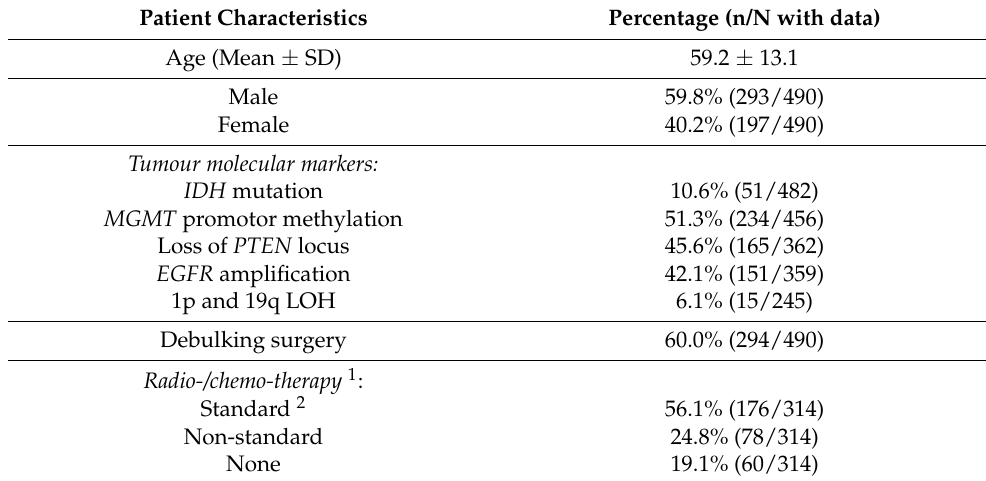
Table 1. Patient